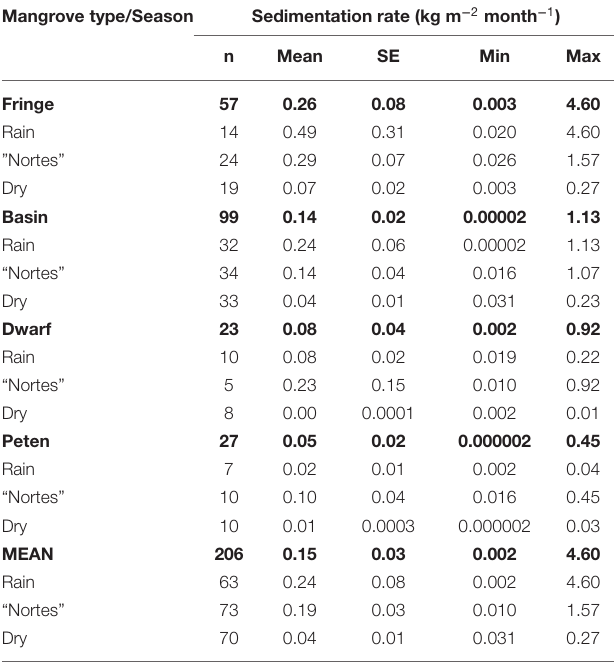
TABLE 1 | Sedimentation rate (kg m − 2 month − 1 ) in four mangroves ecotypes during three climate